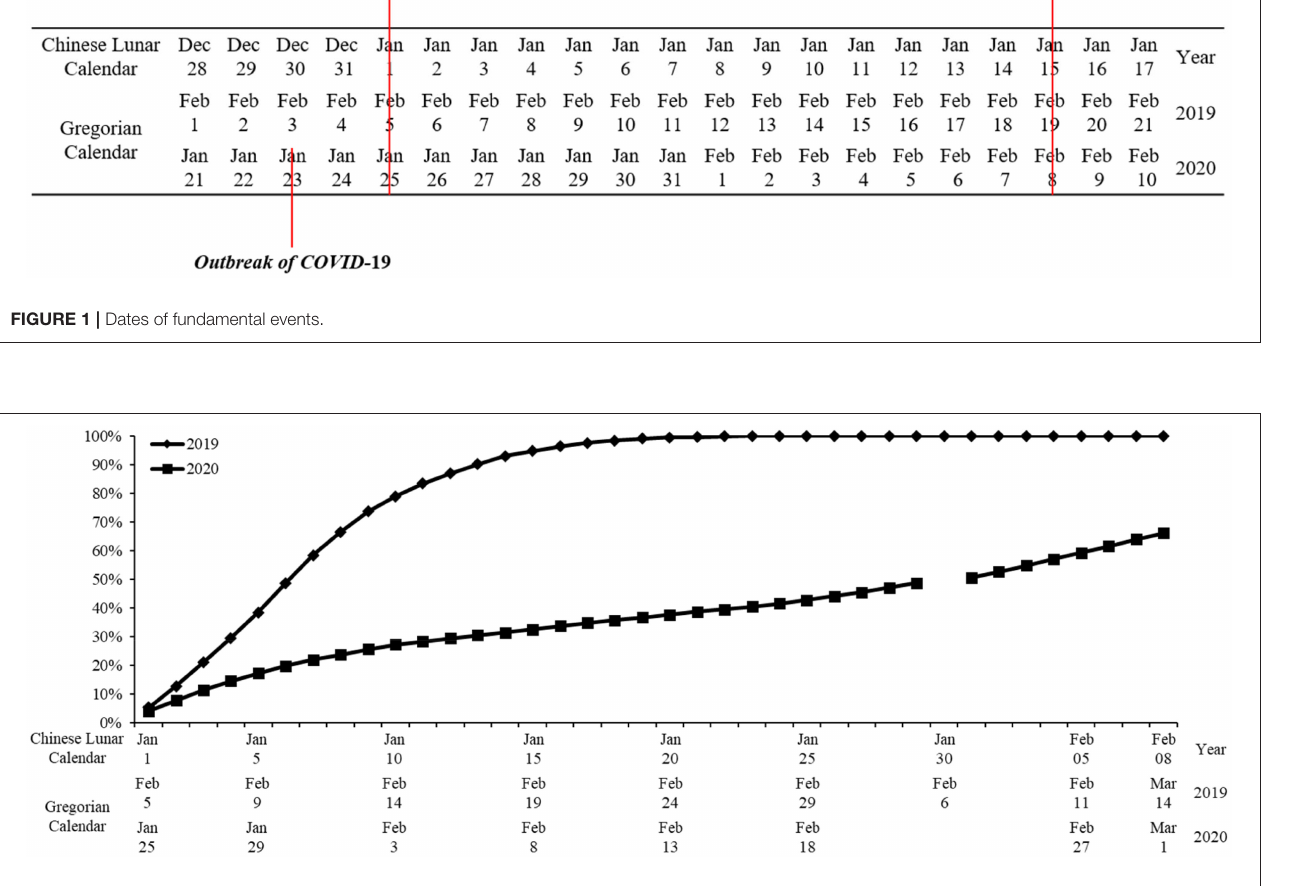
FIGURE 2 | The trend of work resumption rate (WRR) in China. This figure plots the WRR in China from January 1 to February 8 based on the Chinese lunar calendar in 2019 and 2020. For WRR in 2019, t 1 is February 5, 2019 and t 2 are the dates from February 5 to March 14, 2019 corresponding to the horizontal axis; t ′ 1 is January 21, 2019 and t ′ 2 is February 5, 2019. For WRR in 2020, t 1 is January 25, 2020 and t 2 are the dates from January 25 to March 1, 2020 corresponding to the horizontal axis; t